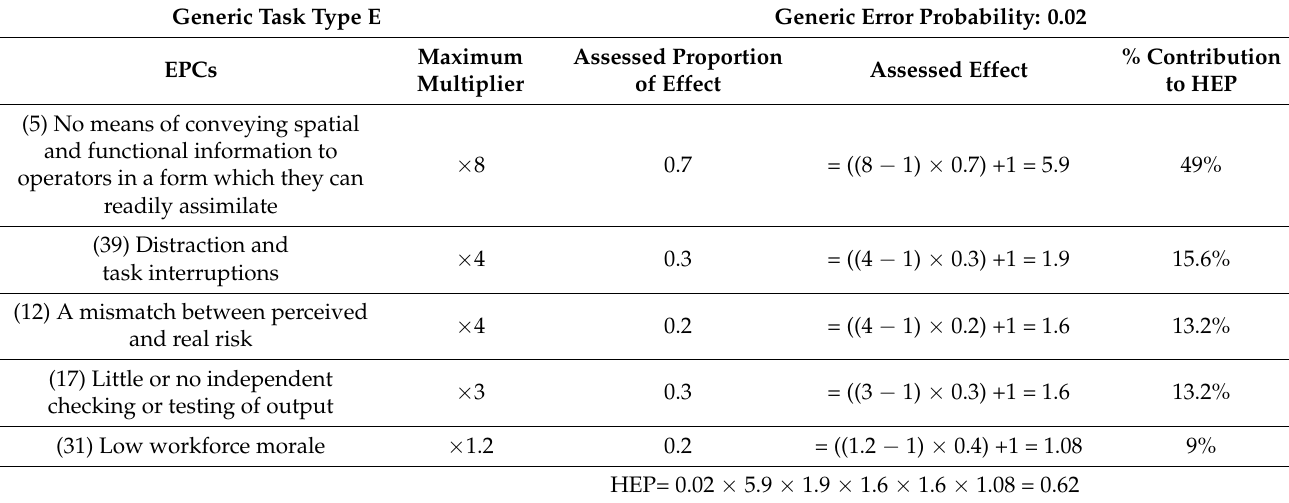
Table 4. HEART calculation of the human error probability (HEP) for brackets 1